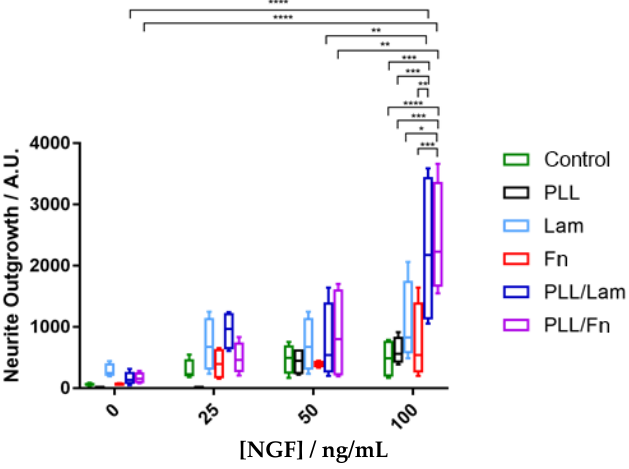
Figure 4. Quantification of neurite extension. The PC12 cells were grown on various coatings over a period of five days and in the presence of 0, 25, 50, and 100 ng/mL NGF. Over fifty fields of view were analysed for each condition. The results indicated a two-fold greater neurite outgrowth occurring on substrata containing the dual-component coatings of poly-L-lysine/laminin and poly-L-lysine/fibronectin with increasing NGF concentrations. Results are presented as minimum, 1st quartile, median, 3rd quartile, and maximum. “*” indicates the degree of statistically significant differences.